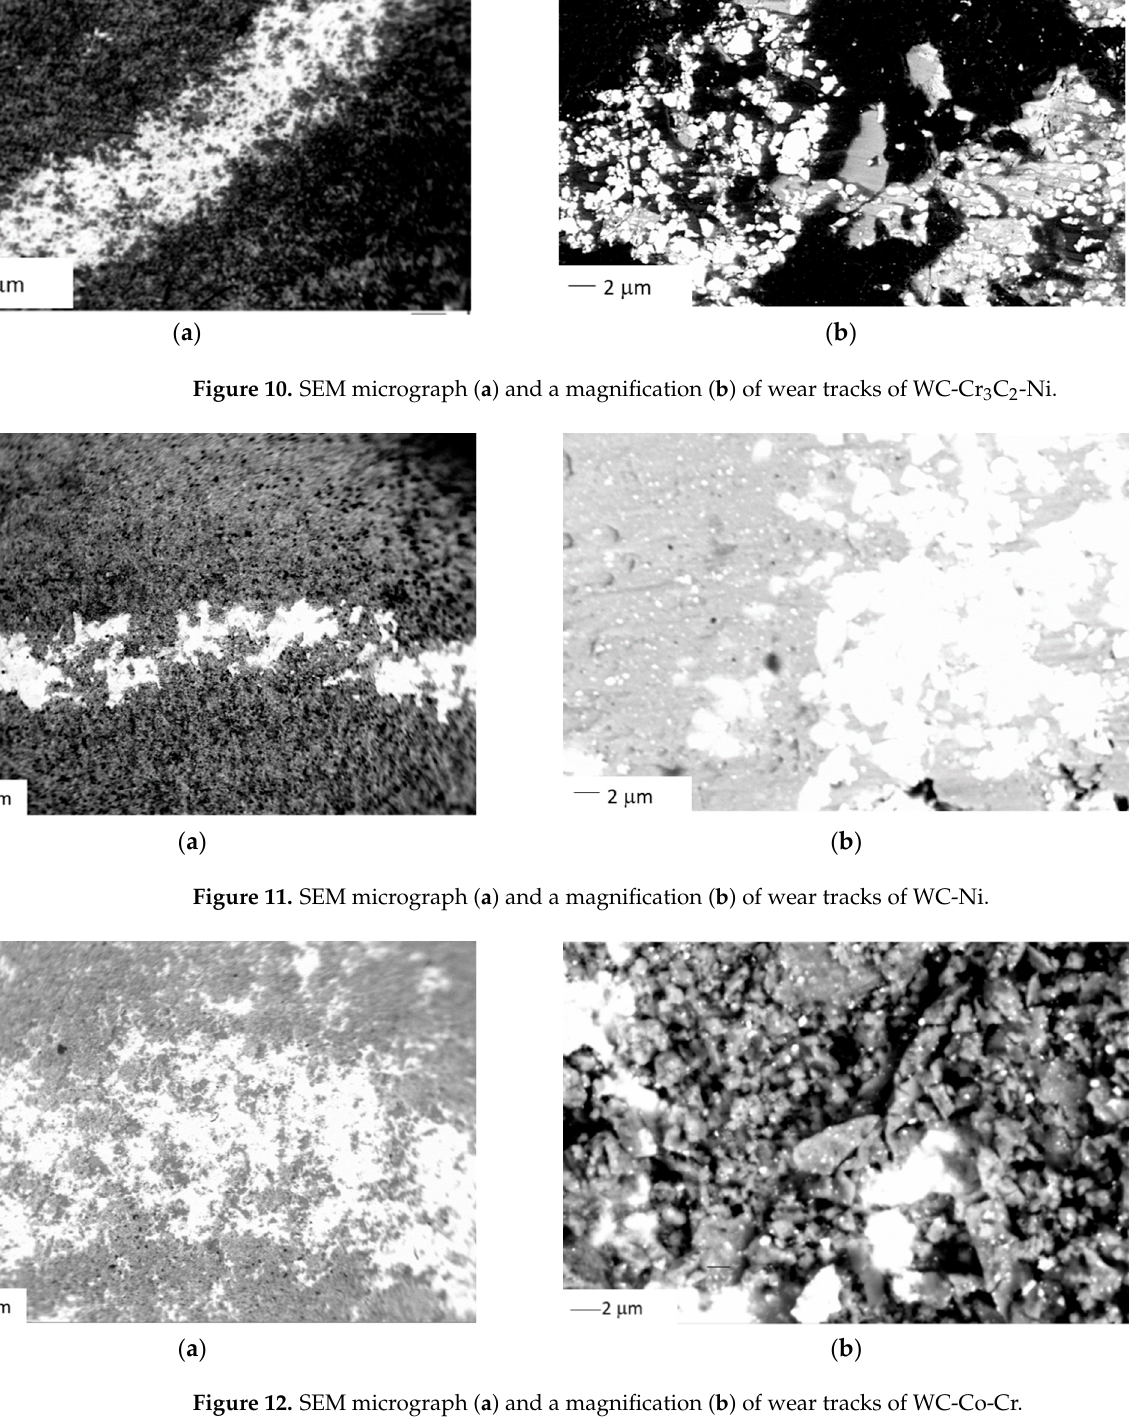
( b ) Figure 13. SEM micrograph ( a ) and a magnification ( b ) of wear tracks of Cr 3 C 2 -NiCr. ( a ) ( b ) Figure 14. SEM micrograph ( a ) and a magnification ( b ) of wear tracks of WC-Co.